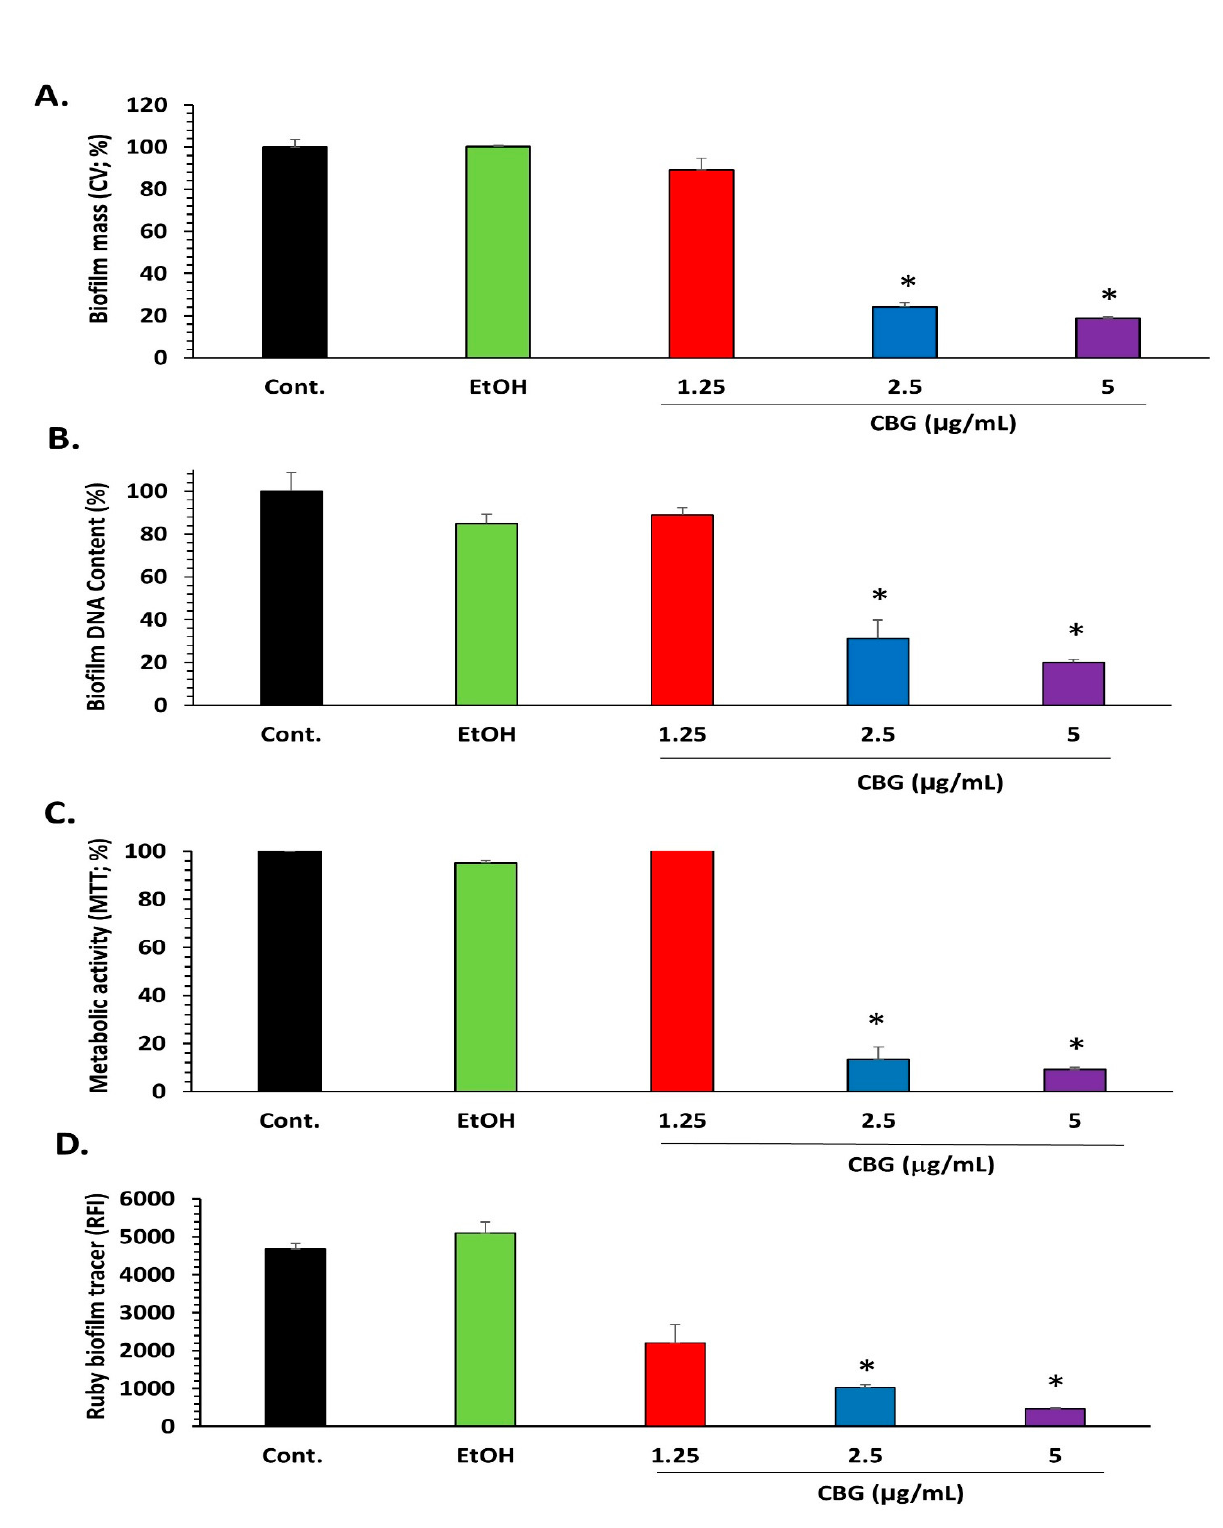
Figure 1. Anti-biofilm activity of CBG on S. mutans . ( A ) Biofilm mass of S. mutans that have been incubated in the absence or presence of various CBG concentrations or respective ethanol concentrations for 24 h as determined by crystal violet staining. n = 3; * p < 0.05. ( B ) Biofilm mass of untreated and CBG-treated S. mutans as determined by DNA content. n = 3; * p < 0.05. ( C ) Metabolic activity as measured by MTT reduction of the biofilm from untreated and CBG-treated S. mutans . n = 3; * p < 0.05. ( D ) FilmTracer SYPRO Ruby biofilm matrix staining of S. mutans biofilms formed for 24 h in the absence or presence of various concentrations of CBG. n = 3. * p < 0.05 in comparison with untreated bacteria.